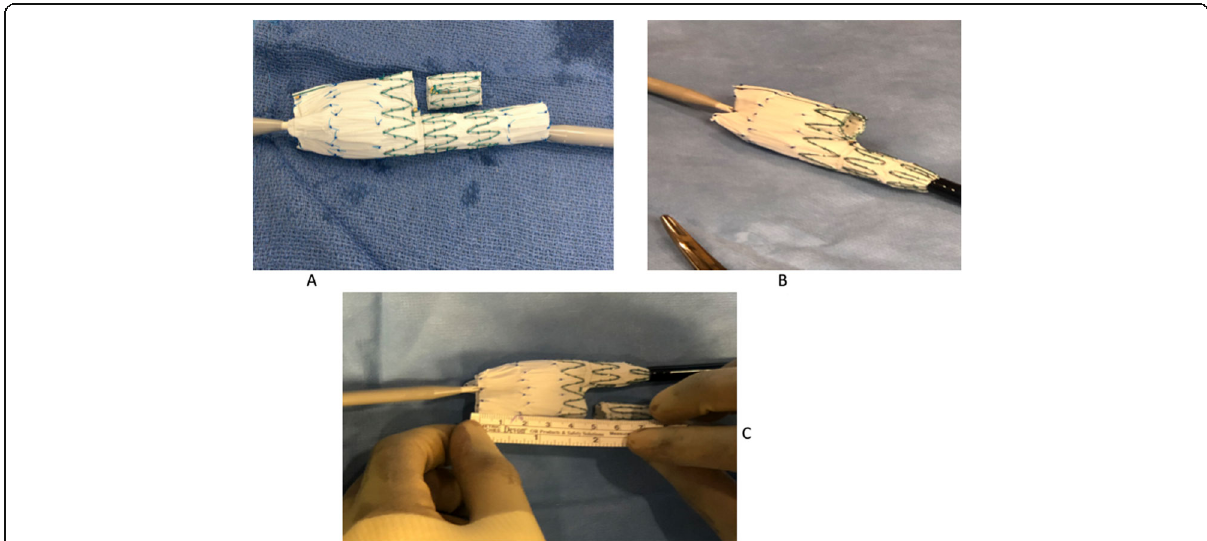
Fig. 1 Creation of inverted iliac limb using the Cook Zenith Fenestrated distal bifurcated body stent graft. a Preparing the inverted limb. Note that the graft is partially deployed; the contralateral limb transected using an ophthalmologic cautery. The check mark is placed in the original orientation to facilitate gate cannulation. b Minimum distance to the flow divider post limb inversion. The length from the top of the stent graft to the gate has been reduced from 76 mm to 51 mm, allowing relining of the entire failed previous EVAR. c Securing the inverted limb to the bifurcated device. The transected limb is now inverted and sewn in place with a 5 – 0 double arm ethibond suture